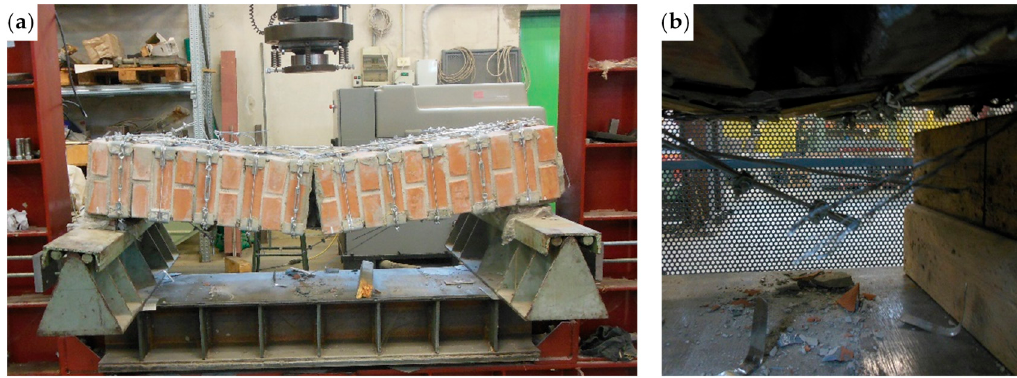
Figure 47. The specimen on the testing machine after the test: ( a ) front view and ( b ) detail of the broken straps under the middle cross-section (back view).